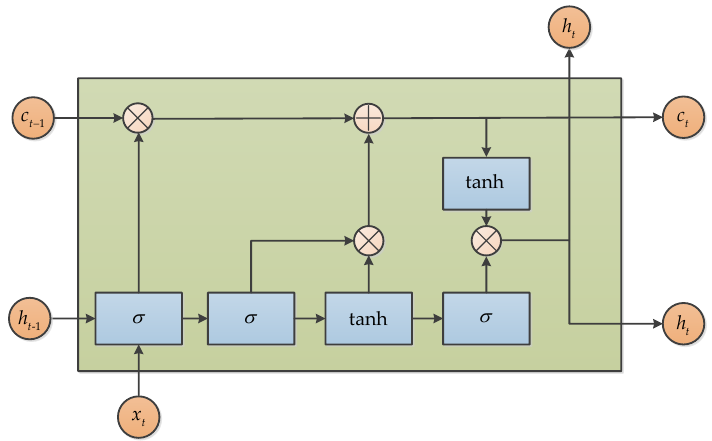
Figure 18. The basic structure of long short term memory.